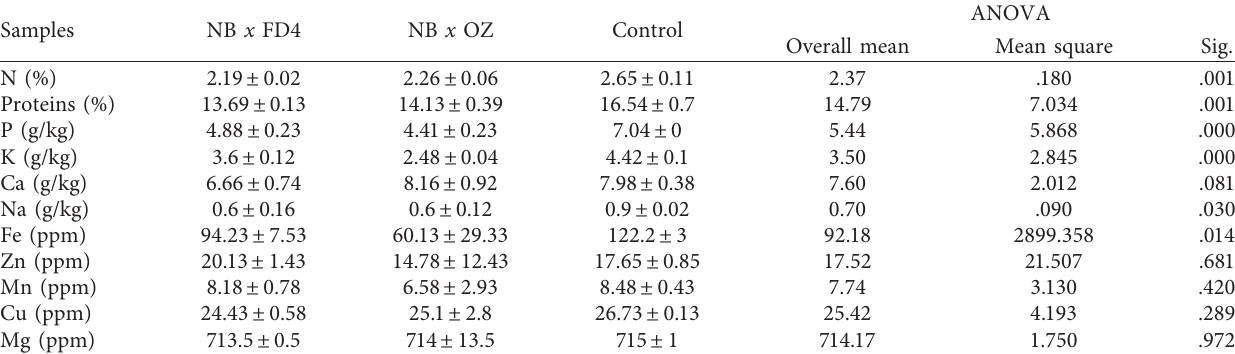
Table 2: Statistical analysis of the mineral composition of fig seeds as affected by pollination.